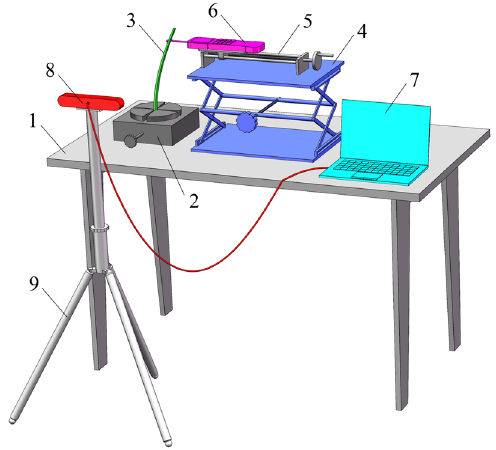
Figure 1. Experimental system. (1) horizontal testbed; (2) clamp; (3) stalk; (4) lift platform; (5) horizontal hand-operated stand; (6) digital force meter; (7) personal computer; (8) ZED 2 camera; (9)